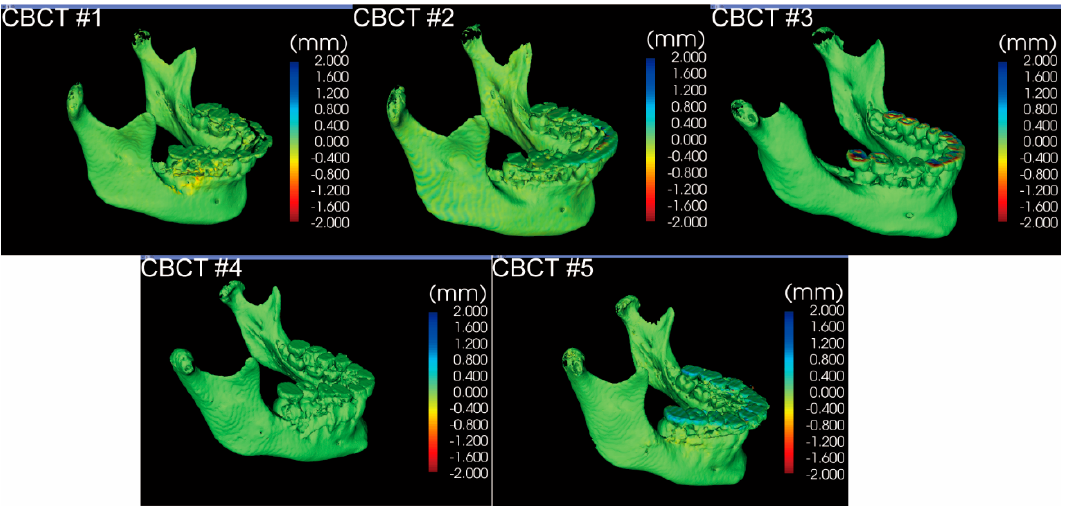
Figure 2. The model-to-model distance analysis in the 3D Slicer software for two segmentations performed by one examiner for each CBCT.